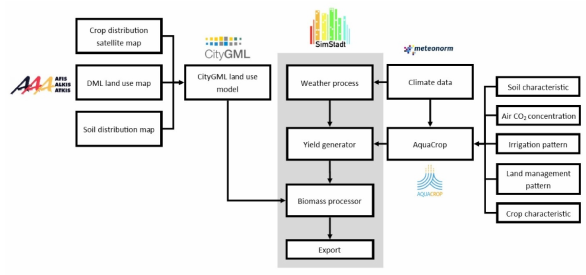
Figure 8. Newly developed SimStadt’s bio-energy